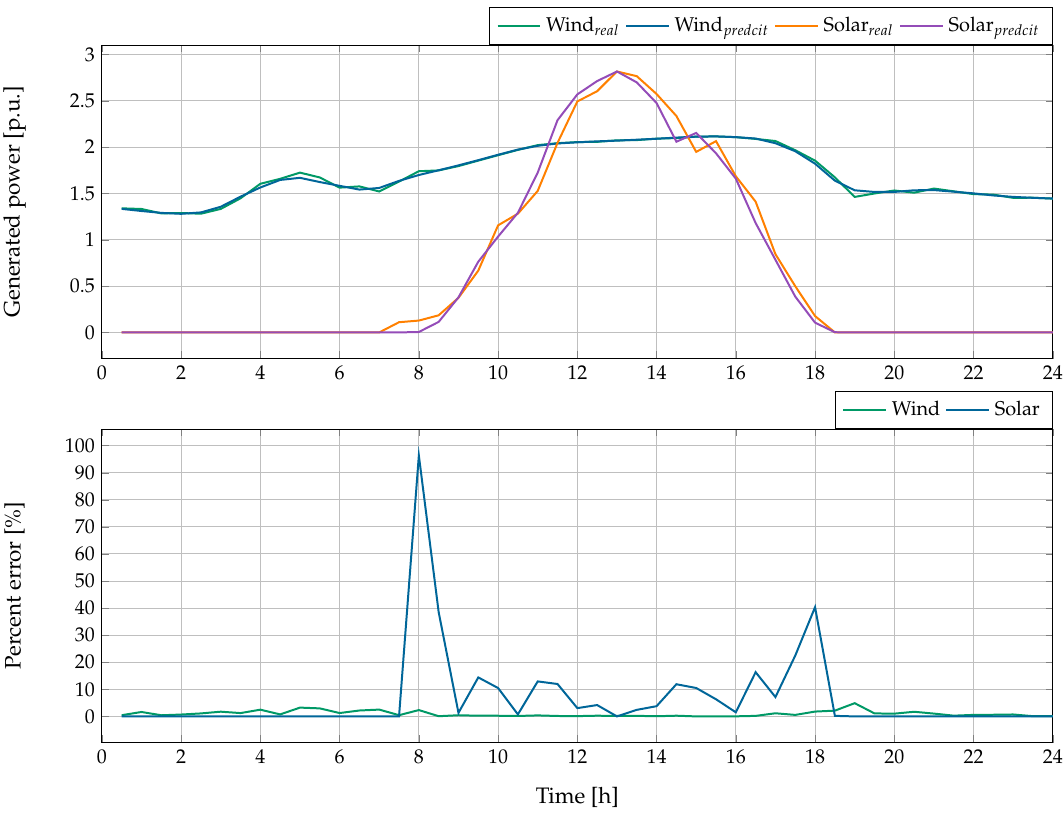
Figure 6. Real and estimation